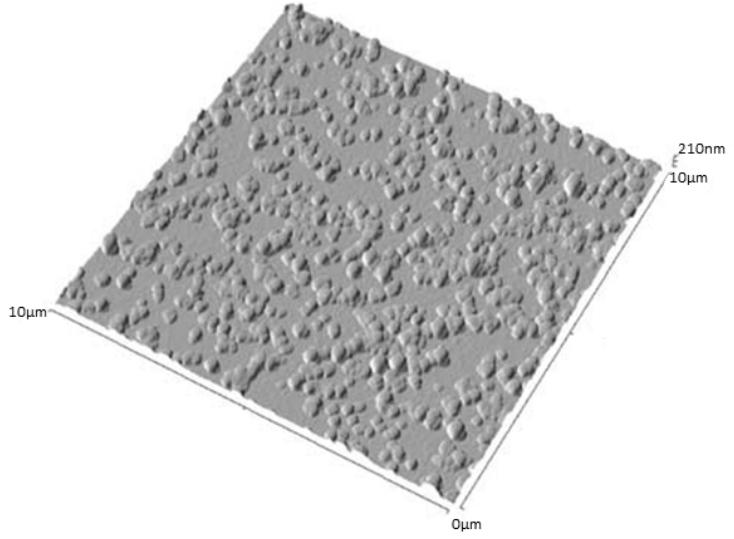
Figure 36. Non-contact mode AFM images of SLNs based on mixtures of 20